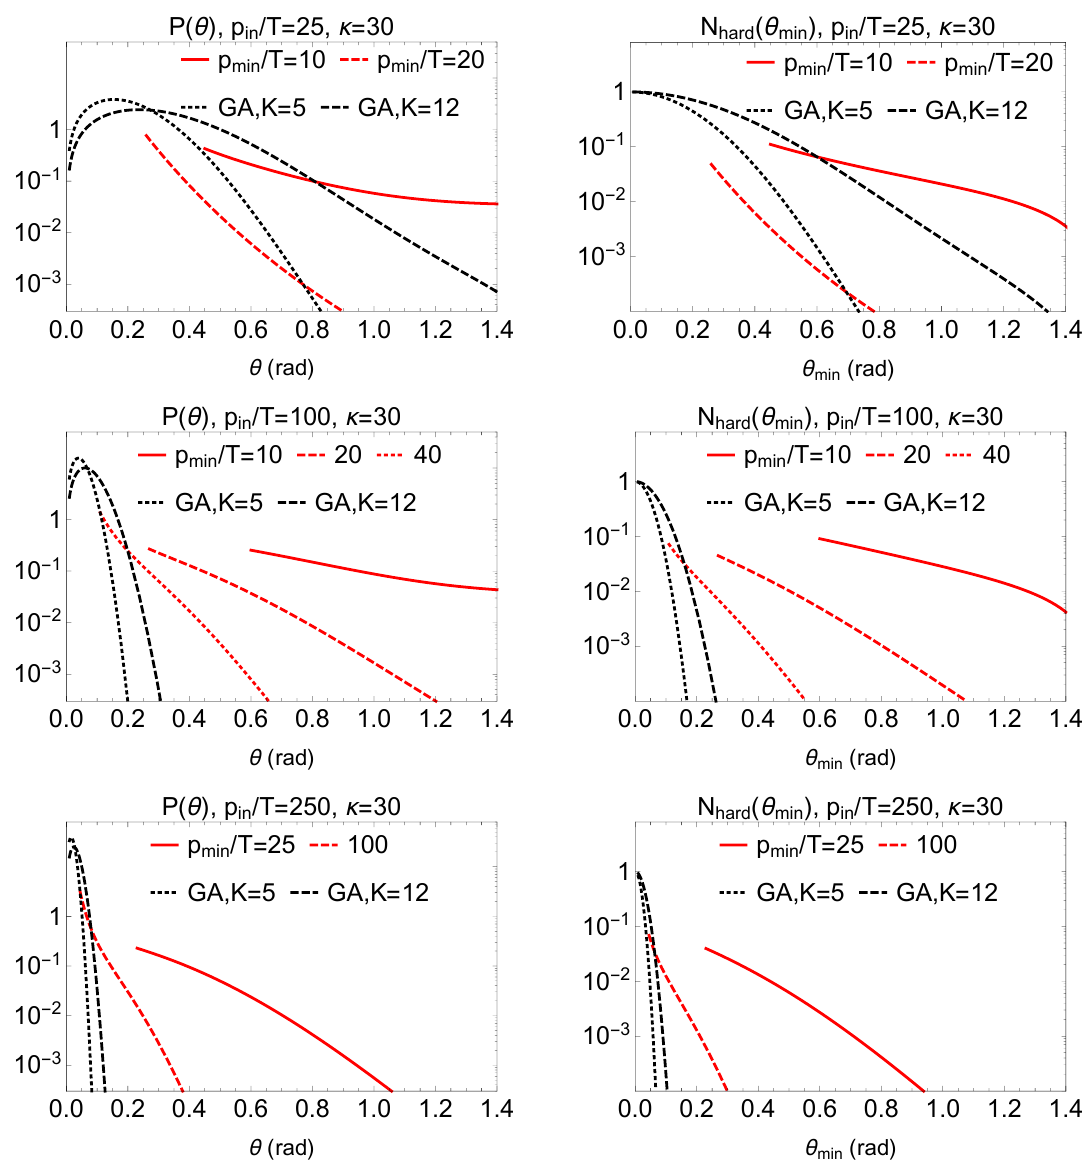
Figure 6 . P ( (cid:18) ) (left column) and N hard ( (cid:18) min ) (right column) for an incident gluon with p in =T = 25 (upper row) and p in =T = 100 (middle row). In the top four panels, the solid red curves (dashed red curves) show our results when we include all partons with p > p min = 10 T (20 T ). In the middle panels, the dotted red curves show our results when we only include partons with p > p min = 40 T . In the lower panels we consider an incident gluon with p in =T = 250 that yields a scattered parton with p > p min = 25 T or 100 T . We have set (cid:20) = 30, corresponding to g s (cid:25) 1 : 5, T = 0 : 4 GeV and (cid:1) t = 3 fm, as discussed in the text. For comparison, we plot P GA ( (cid:18) ) from eq. (3.12) for K = 5 and 12 (black dotted and black dashed curves,